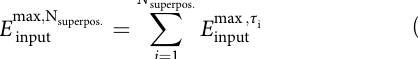
chosen delay time τ . The spectral diversity of the multimode s fi ber ensures that this control is only affecting delays around τ the transmission matrices as a function of wavelength/delay are uncorrelated over a suf fi cient bandwidth/time interval 21,23,24 .